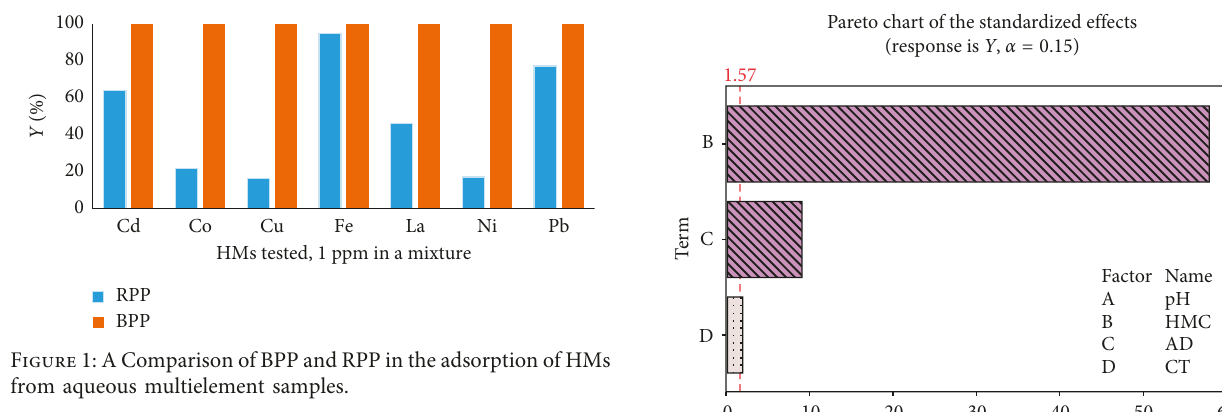
Pareto chart of the standardized effects (response is Y , α = 0.15)